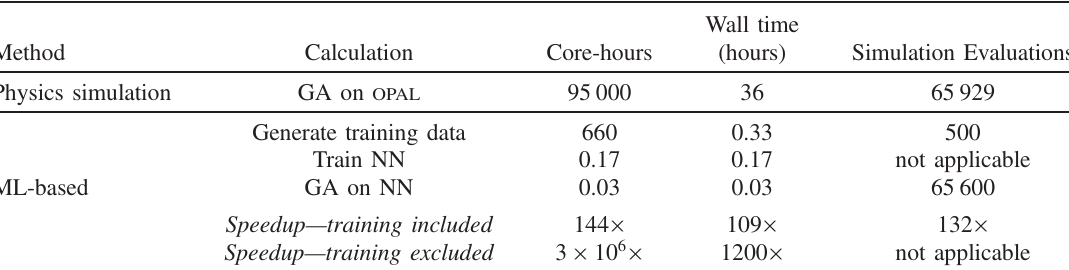
TABLE III. Comparison of computing resources: core-hours, wall time, and number of simulation evaluations required for running the GAwith the physics simulation and the GAwith the NN. Here we show only results for the 40 nC bunch charge, but details on 1 nC bunch charge can be found in the Appendix. When running the same GA with the NN, 3 × 10 6 times fewer computing resources are required. When including the resources needed to generate the training data (as might be done for initial design optimization), we still have a factor improvement of 144 in terms of core-hours required. Note that although we showed results in the previous section that suggest there would be further reduction of the computational resources by conducting iterative retraining (e.g., 360 times fewer core-hours for ten iterations), we do not include results for this in the table because we did not repeat this with the physics simulation itself.